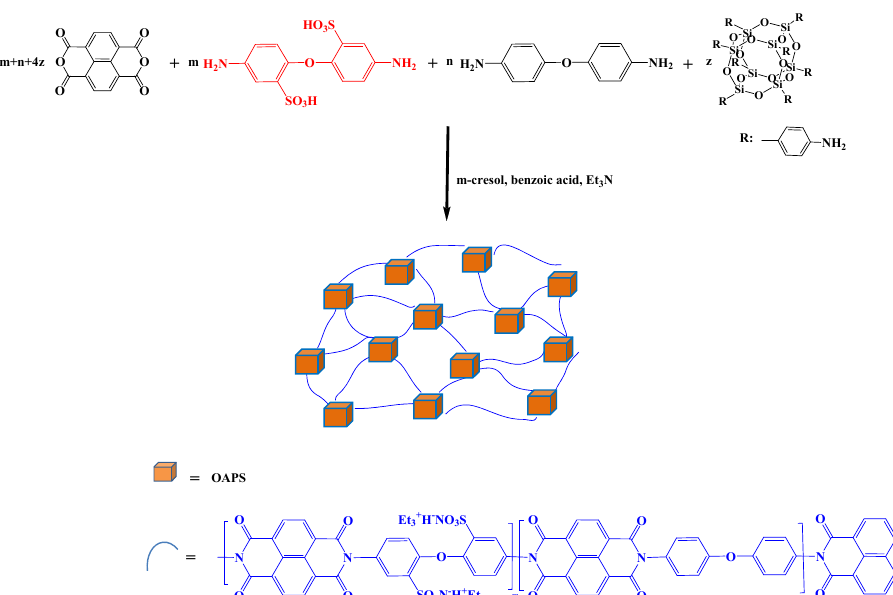
Figure 15. Preparation of POSS cross-linked cross-linked sulfonated PIs (SPIs) [84]. Reproduced with